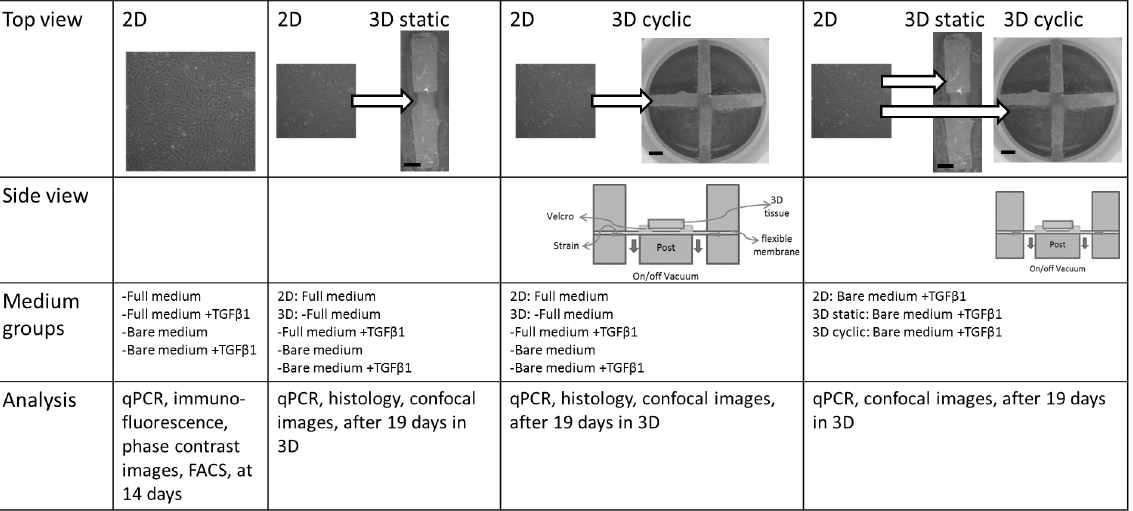
Figure 1. Schematic overview of the experimental set up. Top view shows 2D cell layer and 3D constructs on Bioflex plates with 2 (static strain protocol) or 4 (cyclic strain protocol) rectangular Velcro strips glued to the flexible membrane. Scale bar indicates 3 mm. Velcro strips leave space for cell-populated fibrin gels. Side views show schematic cross-section of the Flexcell setup used for cyclic strain application. When vacuum is applied, the flexible membrane is deformed over a rectangular loading post resulting in a uniaxial strain of the membrane and, thus, of the tissue. ECFCs were cultured in full medium, full medium + TGF b 1, bare medium and bare medium + TGF b 1. The bottom row shows analyses performed on the samples.